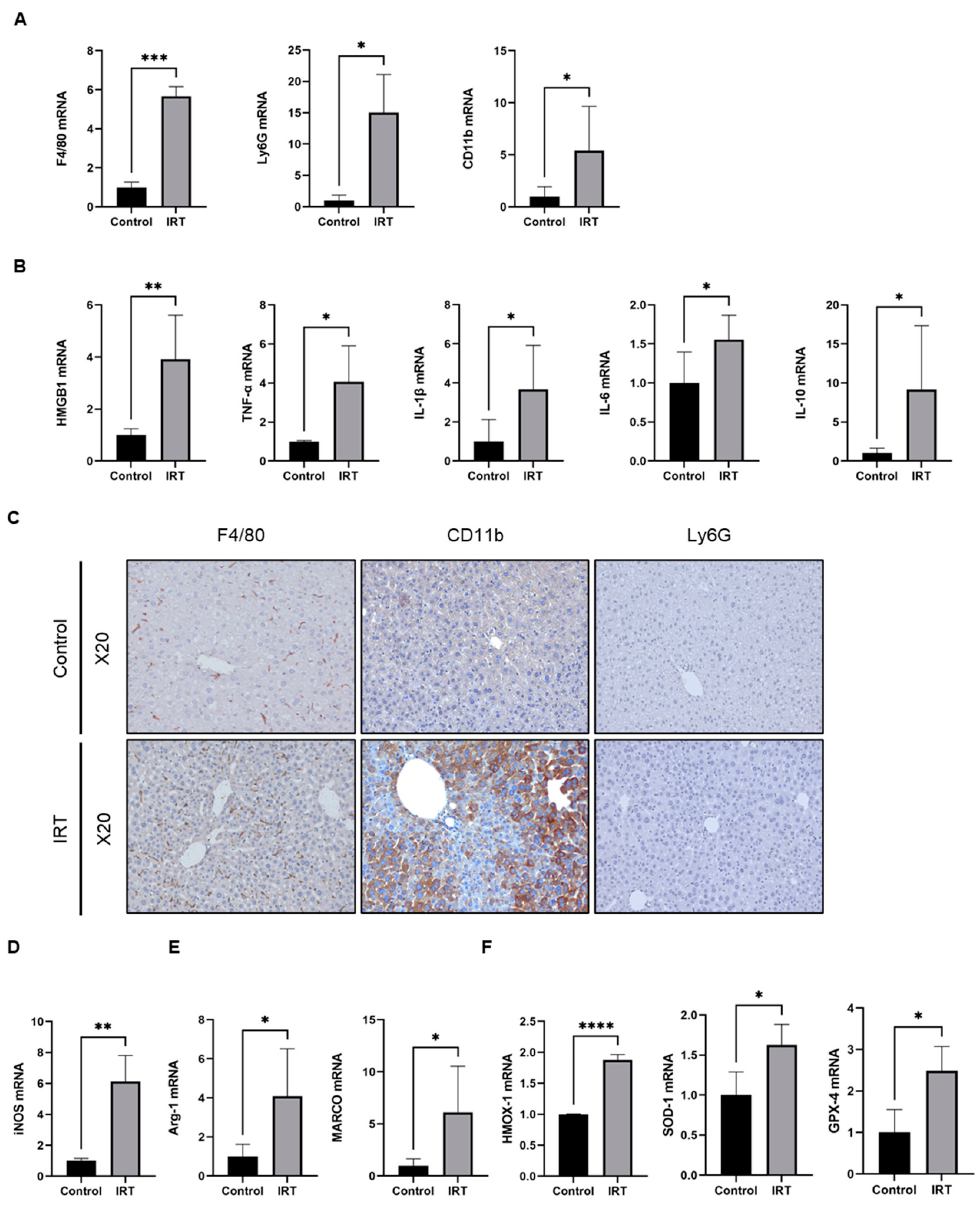
Figure 2. Irinotecan induced activation of macrophages. Mice were intraperitoneally injected with irinotecan hydrochloride (60 mg/kg) or 5% glucose solution thrice a week on alternate days